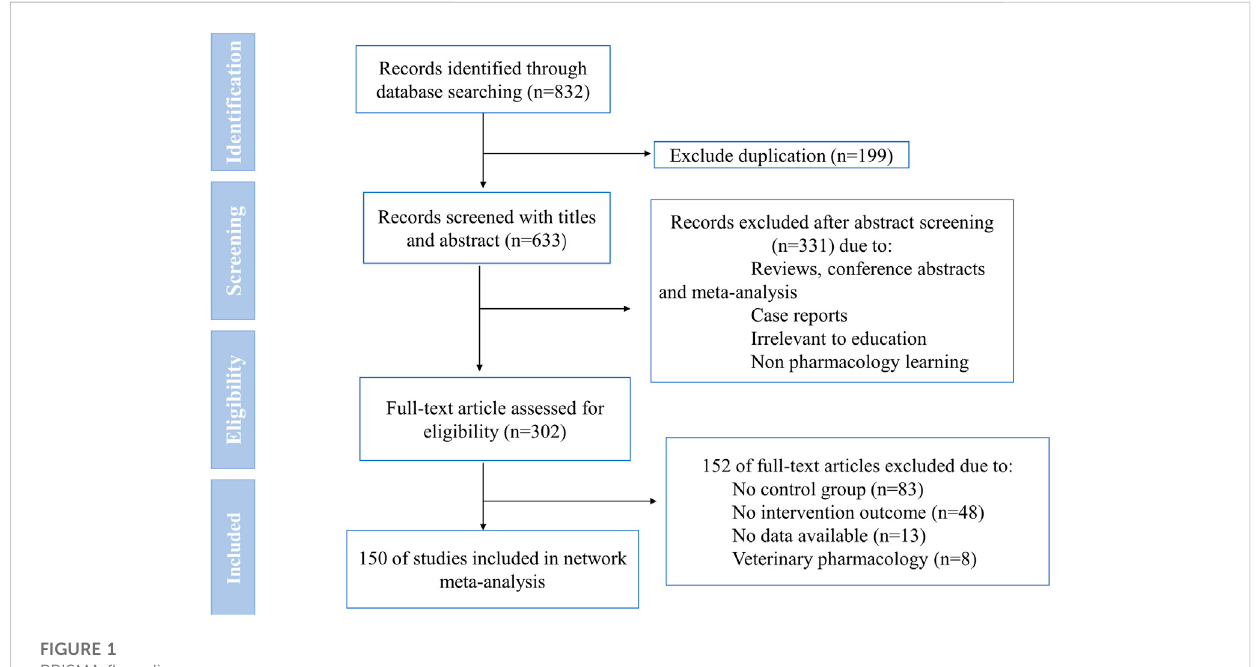
FIGURE 1 PRISMA fl ow